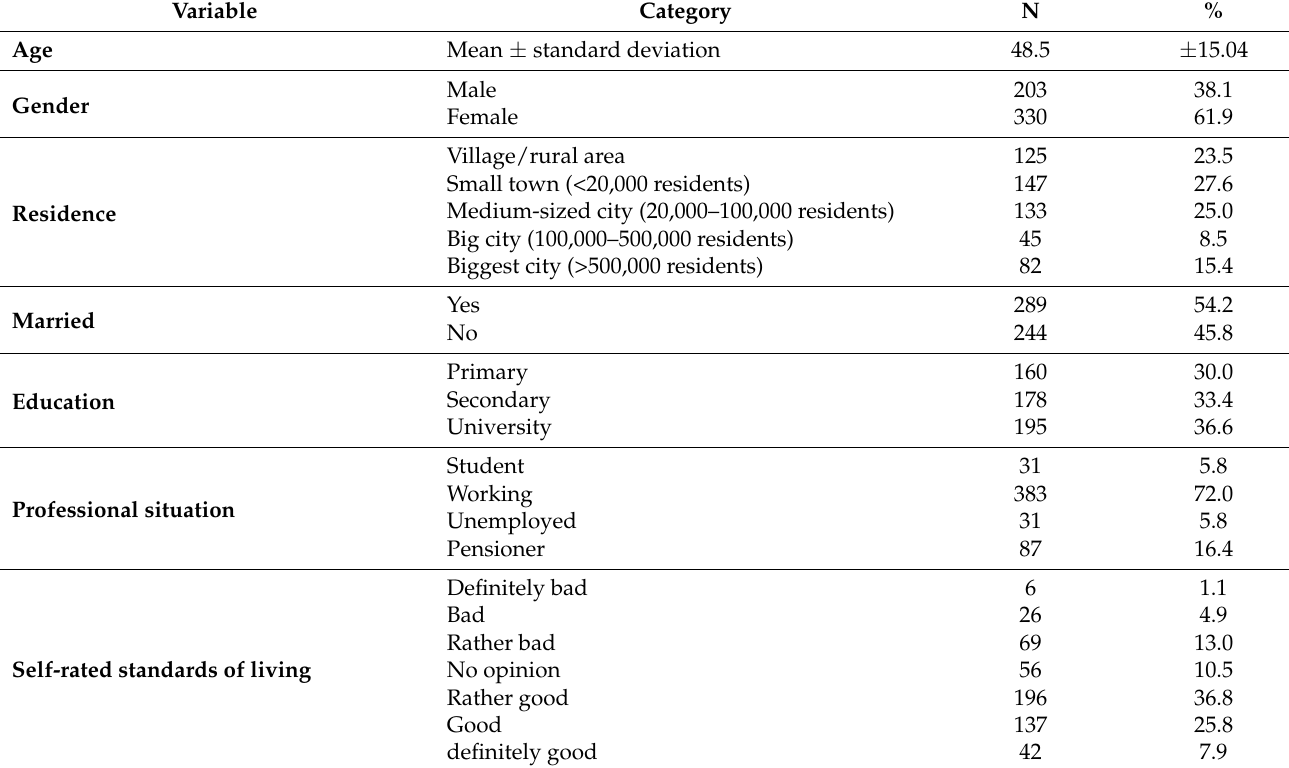
Table 1. Characteristic of the